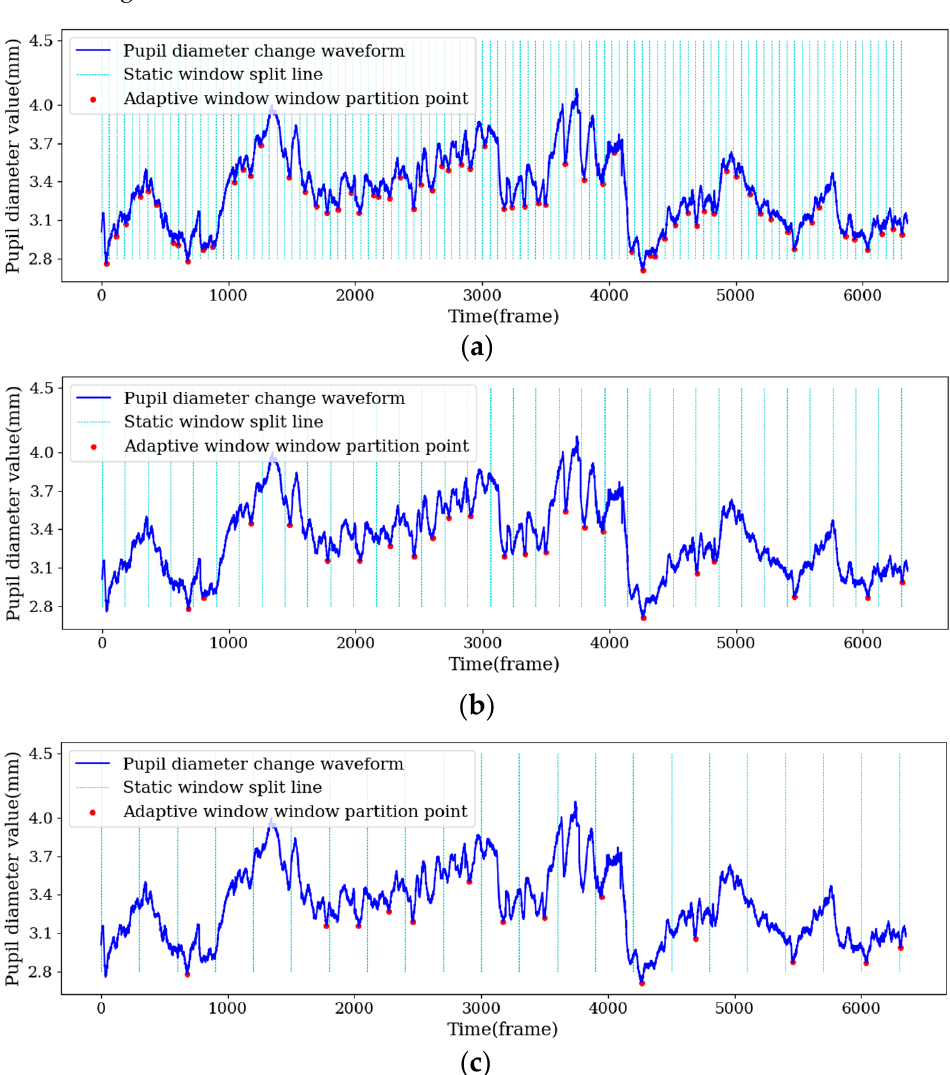
Figure 6. AWS and SWS pupil diameter diagrams: ( a ) 1 s static window and adaptive window for n = 30, ( b ) 3 s static window and adaptive window for n = 90, ( c ) 5 s static window and adaptive window for n = 150.